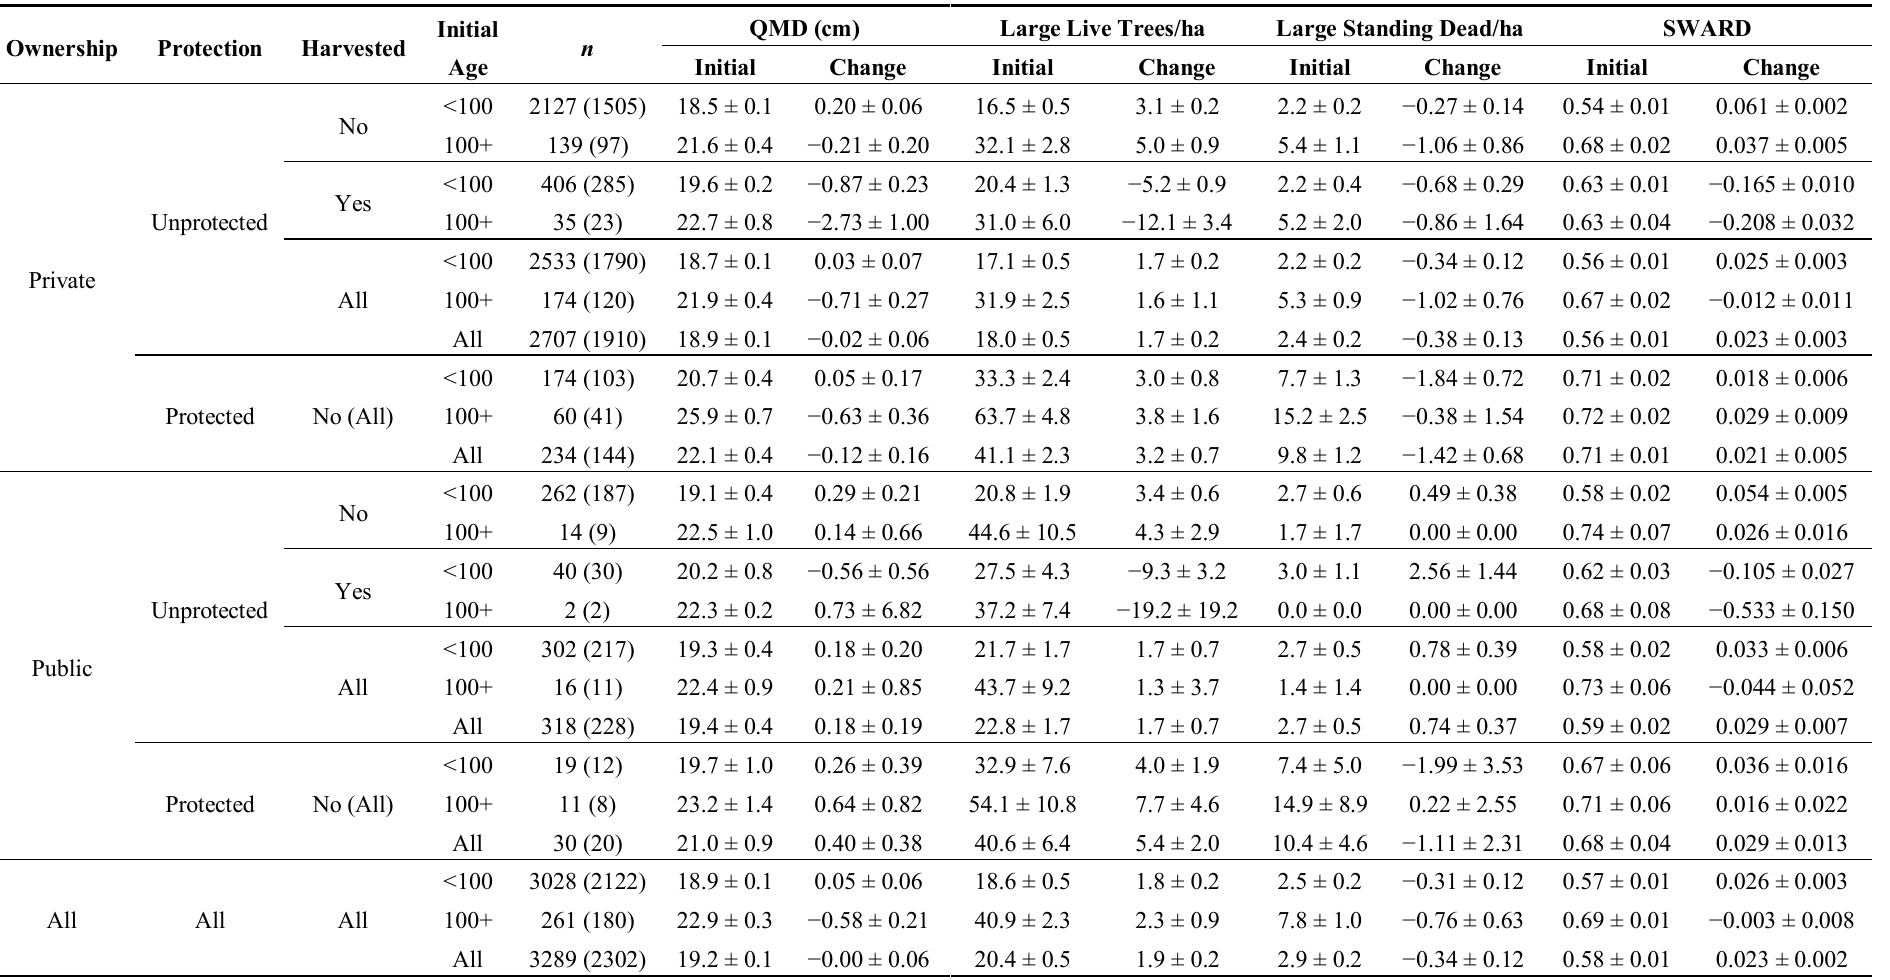
Table 4. Key structural measures and their change (mean plus or minus one standard error) by ownership, protection status, and harvest. Initial refers to the 2003–2007 time period, while change is for a five-year interval (nominally through 2008–2012). Number of plots used for large standing dead (shown in parentheses) is lower due to protocol changes; only plots with valid initial and repeated measurement are used in the